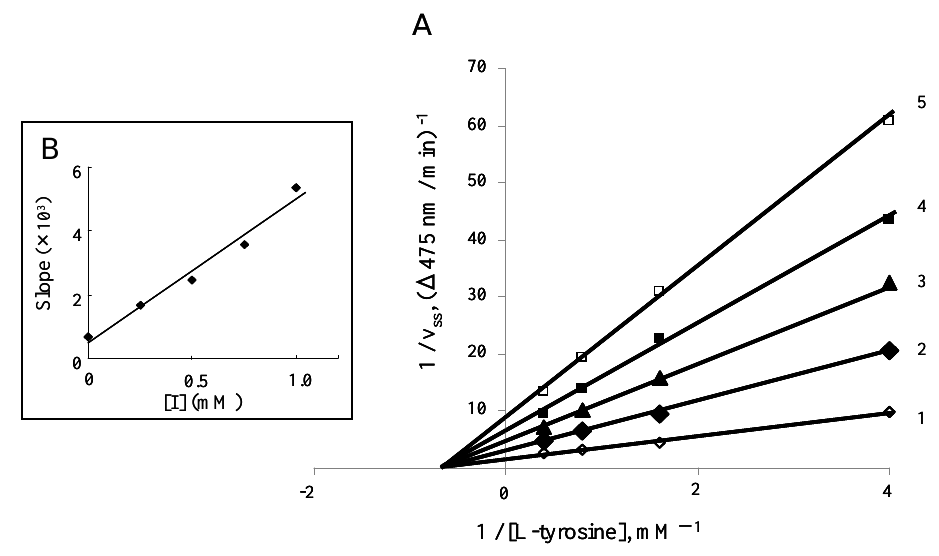
Figure 5. Determination of inhibitory type and inhibition constants of diflunisal on monophenolase activity of mushroom tyrosinase. ( A ) Lineweaver-Burk plots for inhibition of diflunisal on monophenolase activity. The concentrations of diflunisal for curves 1–5 were 0 mM, 0.25 mM, 0.5 mM, 0.75 mM and 1.0 mM, respectively; ( B ) The plots of slope versus the concentration of diflunisal.